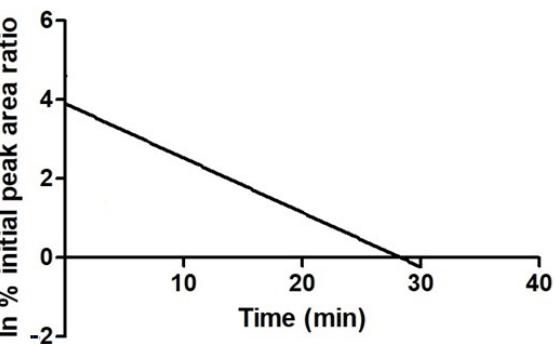
Table 5. Summary of data obtained for JH3 and JH10 and their ester hydrolysis products (M), gen- erated in human liver microsomes (HLMs).